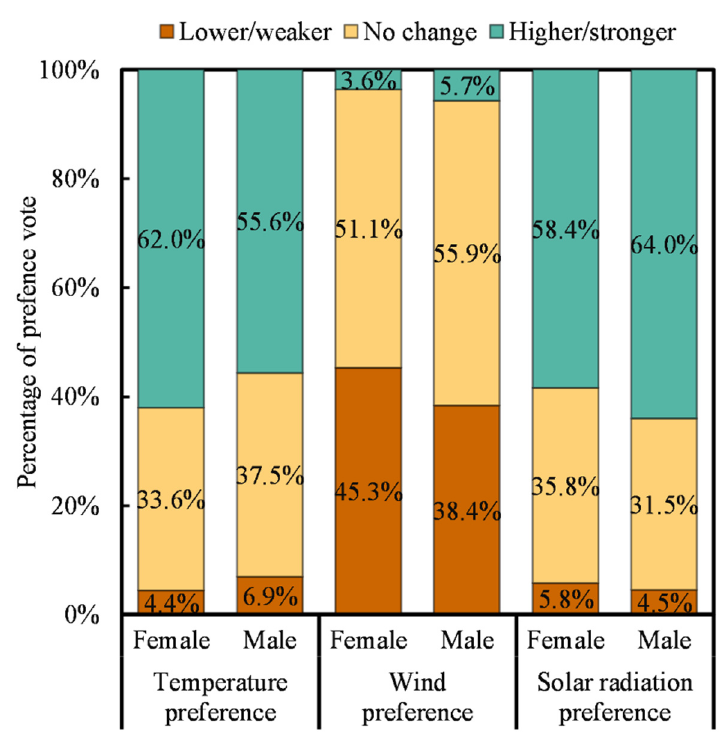
Figure 6. Meteorological parameter preference votes during winter.